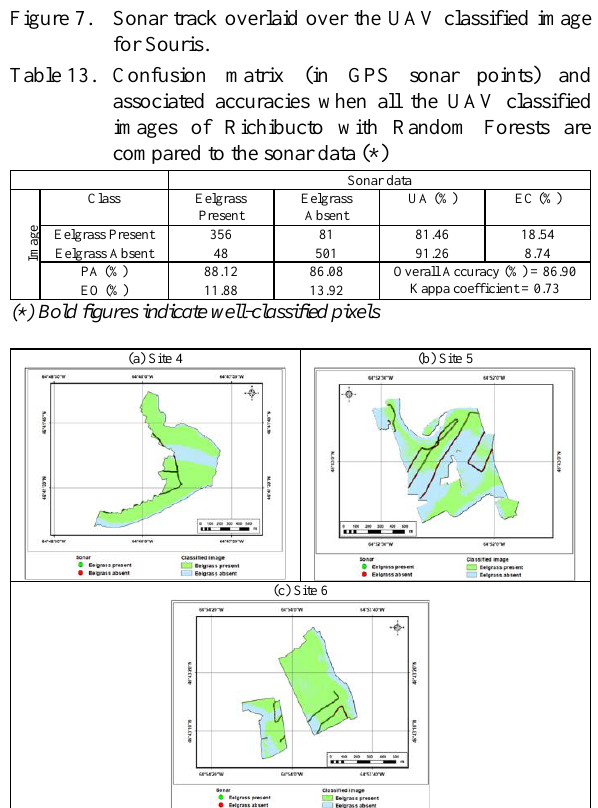
Figure 8. Sonar track overlaid over the UAV classified image for a) Site 4, b) Site 5, and c) Site 6 in